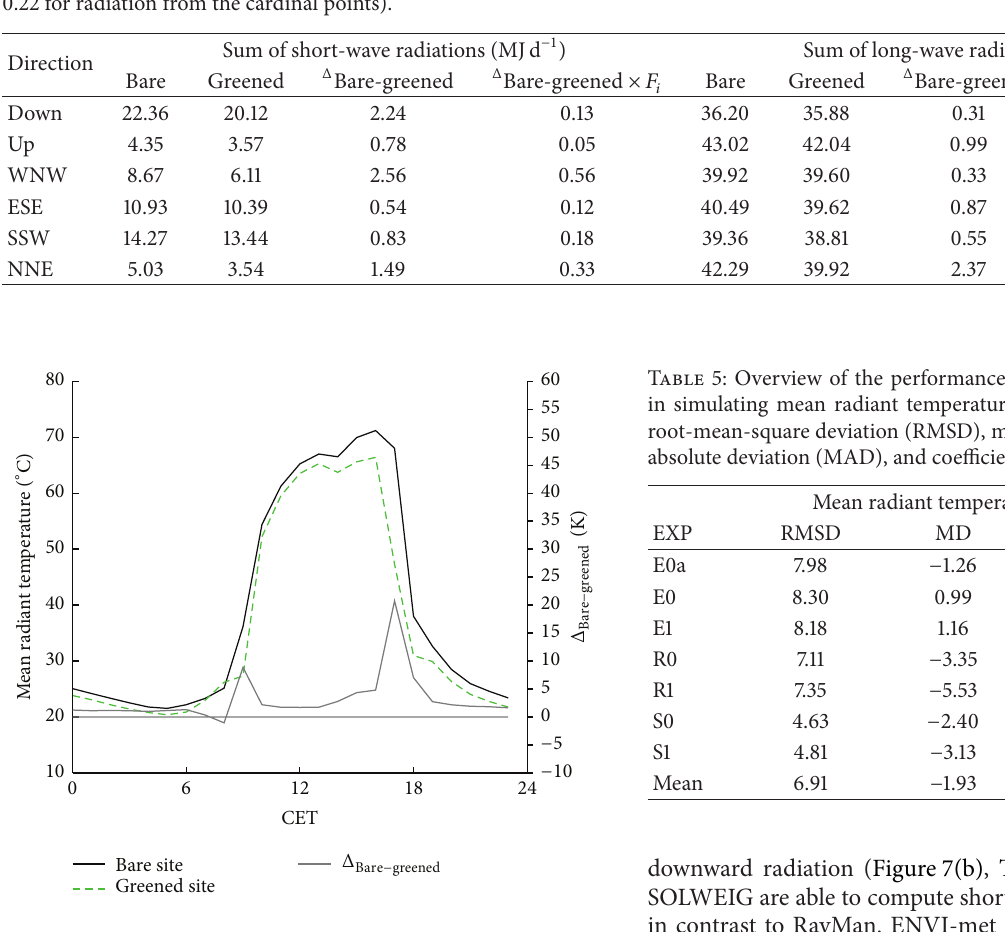
Figure 4: Mean radiant temperature observed at the bare and the greened site in front of the building on 7, 23, 2013.